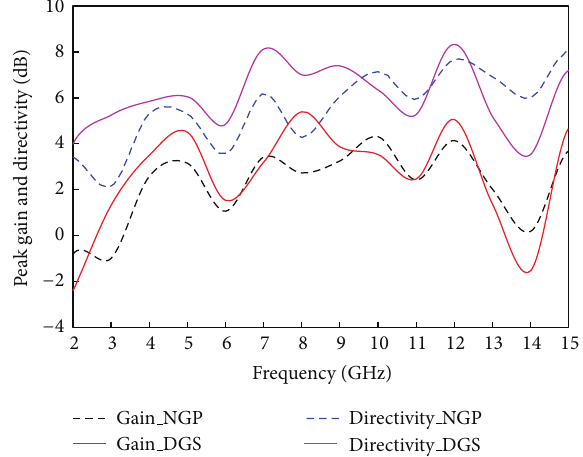
Figure 13: Maximum gain and directivity over the operating band for NGP and